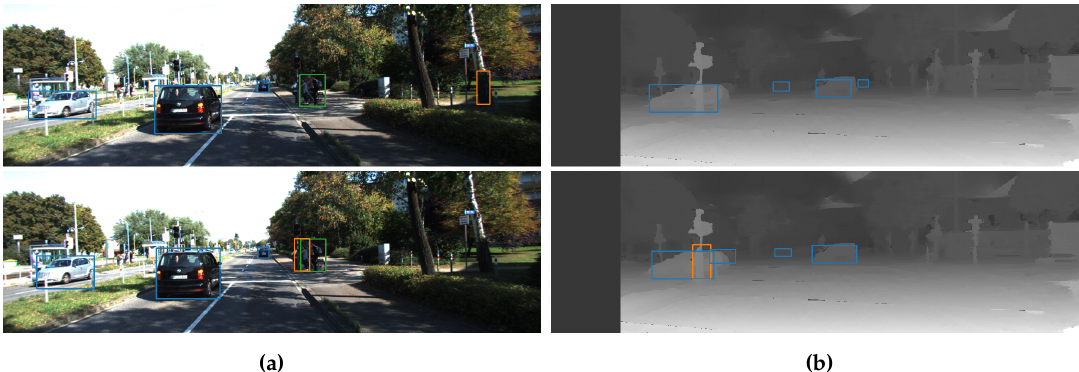
Figure 5. Example images from our validation set of the KITTI dataset. Detections from our best fusion model (RGBD_08) are shown in comparison with our baseline RGB and D models. (Cars—blue; Cyclists—green; Pedestrians—orange). ( a ) Resulting detections of our RGB model (top image) and best fusion model (bottom image). ( b ) Resulting detections of our Depth model (top image) and best fusion model (bottom image). Note that we increased the brightness and contrast of these images for clarity.